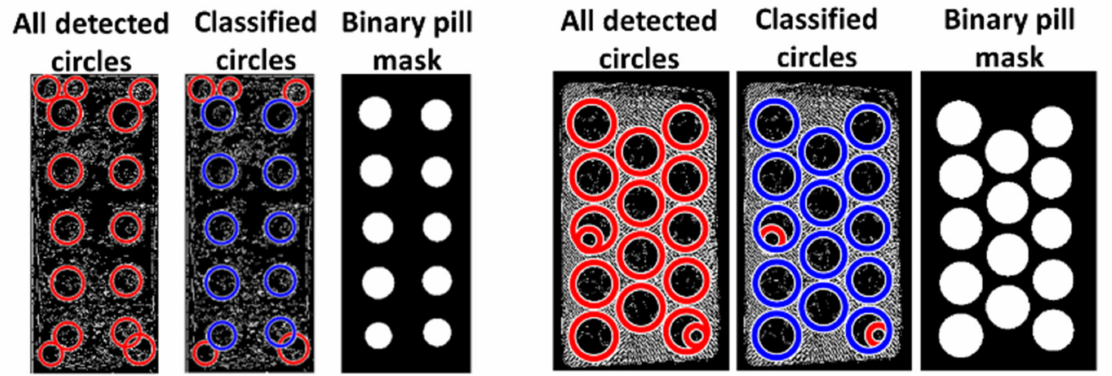
Figure 3. Two examples of the pill mask after classification of